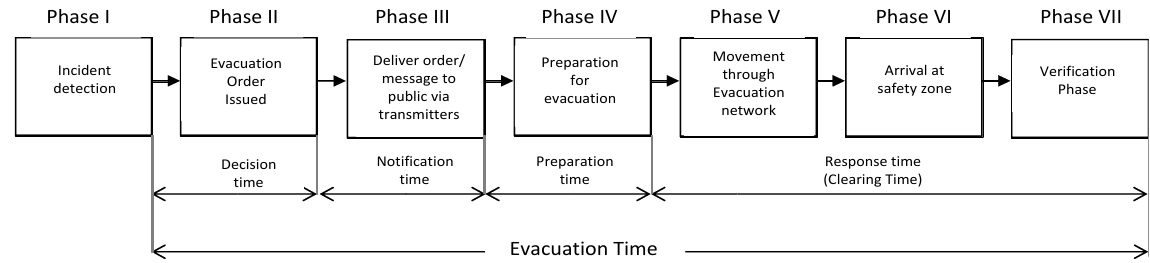
Figure 1. Phases of the evacuation process (Stepanov and Smith,